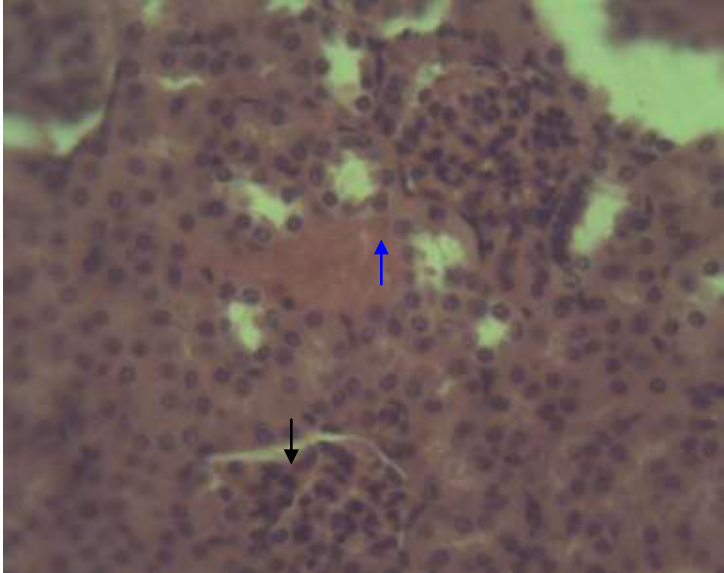
Figure (6):Kidney showing enlargement of glomeruli and the enlargement of the cells lining urinary tubules (H and E